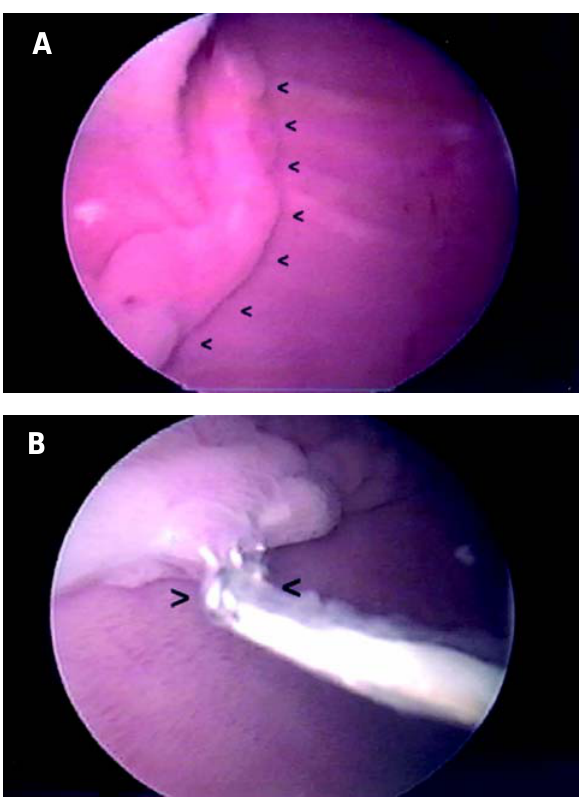
Figure 5 – A) Photograph showing the staple line (multiple arrows) covered by the intestinal mucosa; and B) Single spot where 3 staples were viewed within the reservoir (there is mucus adherent to the